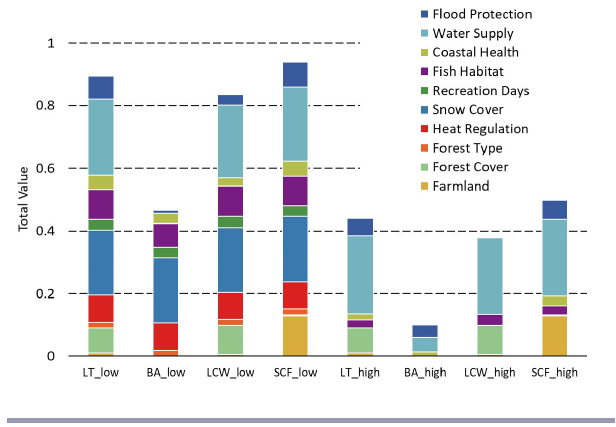
Fig. 4. Overall multiattribute value of each scenario, including the relative contribution of each ecosystem service. Scenarios: low = low emissions, high = high emissions, acronyms defined in Table